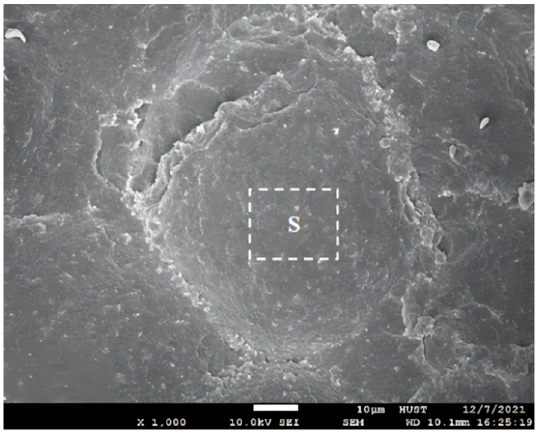
Figure 12. SEM image of the center of the C/C composite matrix after ablation. S represents region in the C/C composite matrix after ablation.